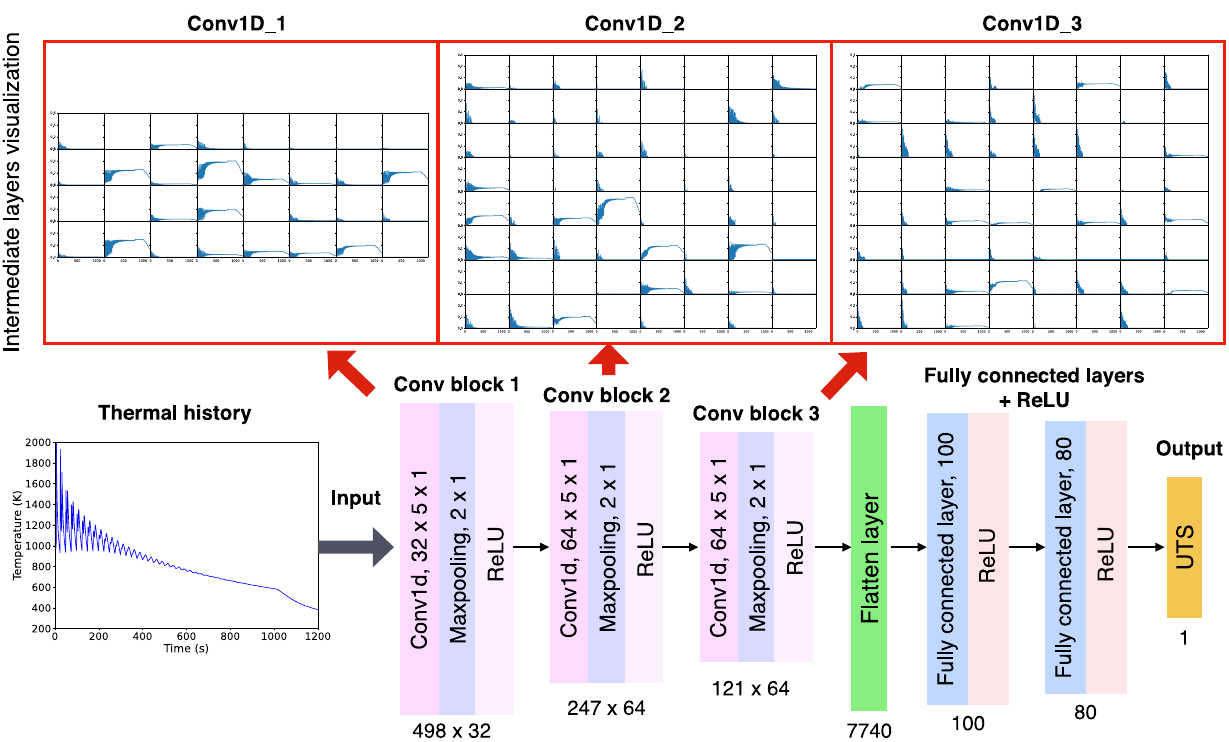
Fig. 7 The CNN structure with intermediate layer visualization. The CNN architecture consists of three convolutional layers with max pooling layer and the ReLU activation, and fully connected layers with the ReLU activation. The top three subplots are the visualization of output of the fi rst, second, and third convolutional layers. The inputs of 1D CNN are the pre-processed thermal histories. The output is mechanical properties Different precipitates can form in two stages: non-equilibrium solidi fi cation and solid-state phase transformation after solidi fi ca-